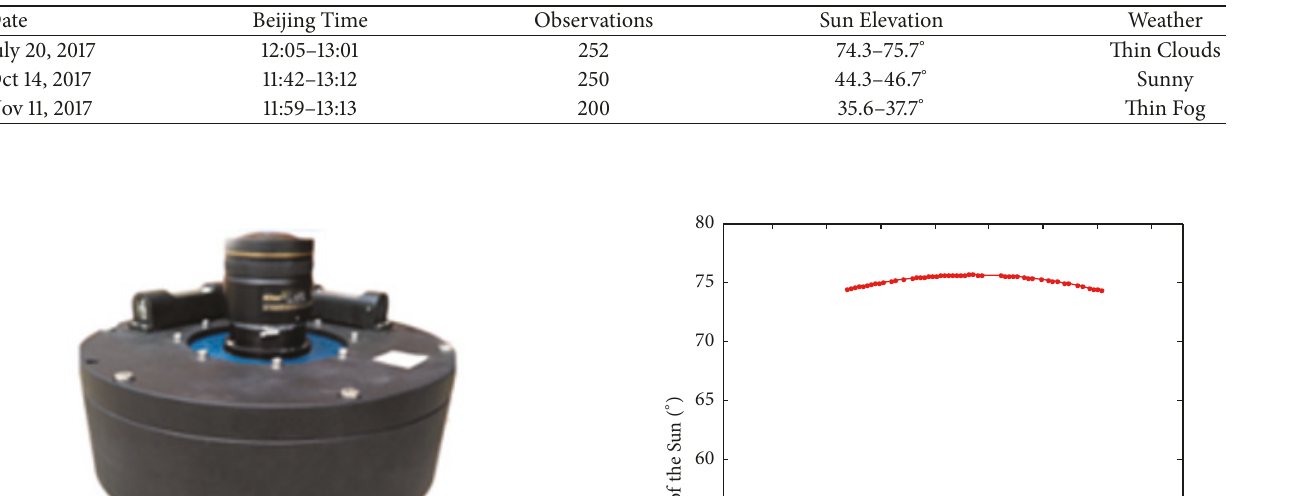
Table 4: Test conditions.